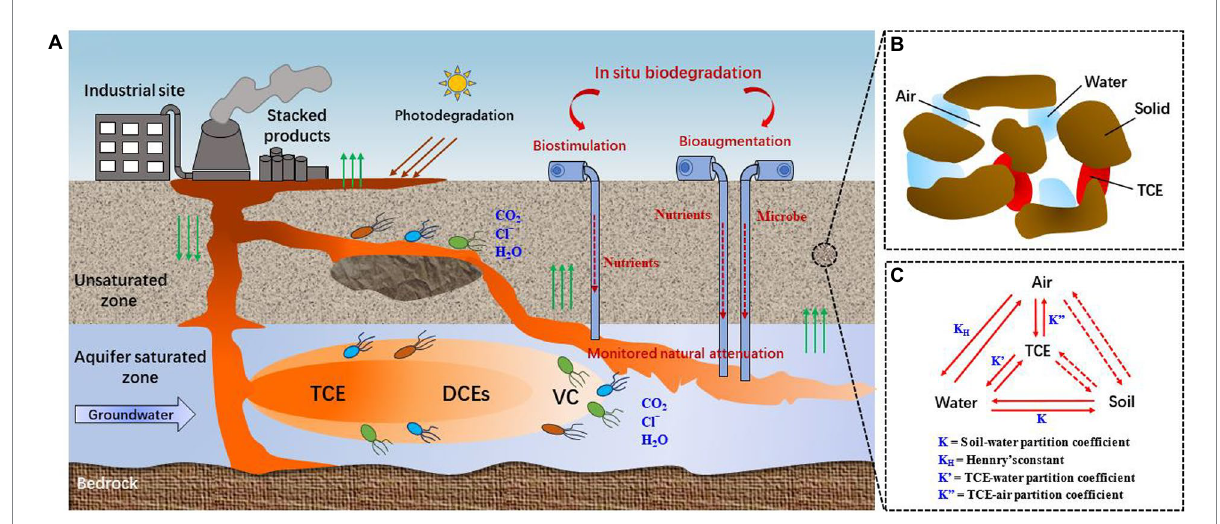
FIGURE 1 Migration and fate of TCE underground. (A) Conceptual model of the transportation of TCE underground [reproduced from (Xing et al., 2022)]; (B) Interactions of different phases of TCE; (C) Phase distribution of TCE in unsaturated